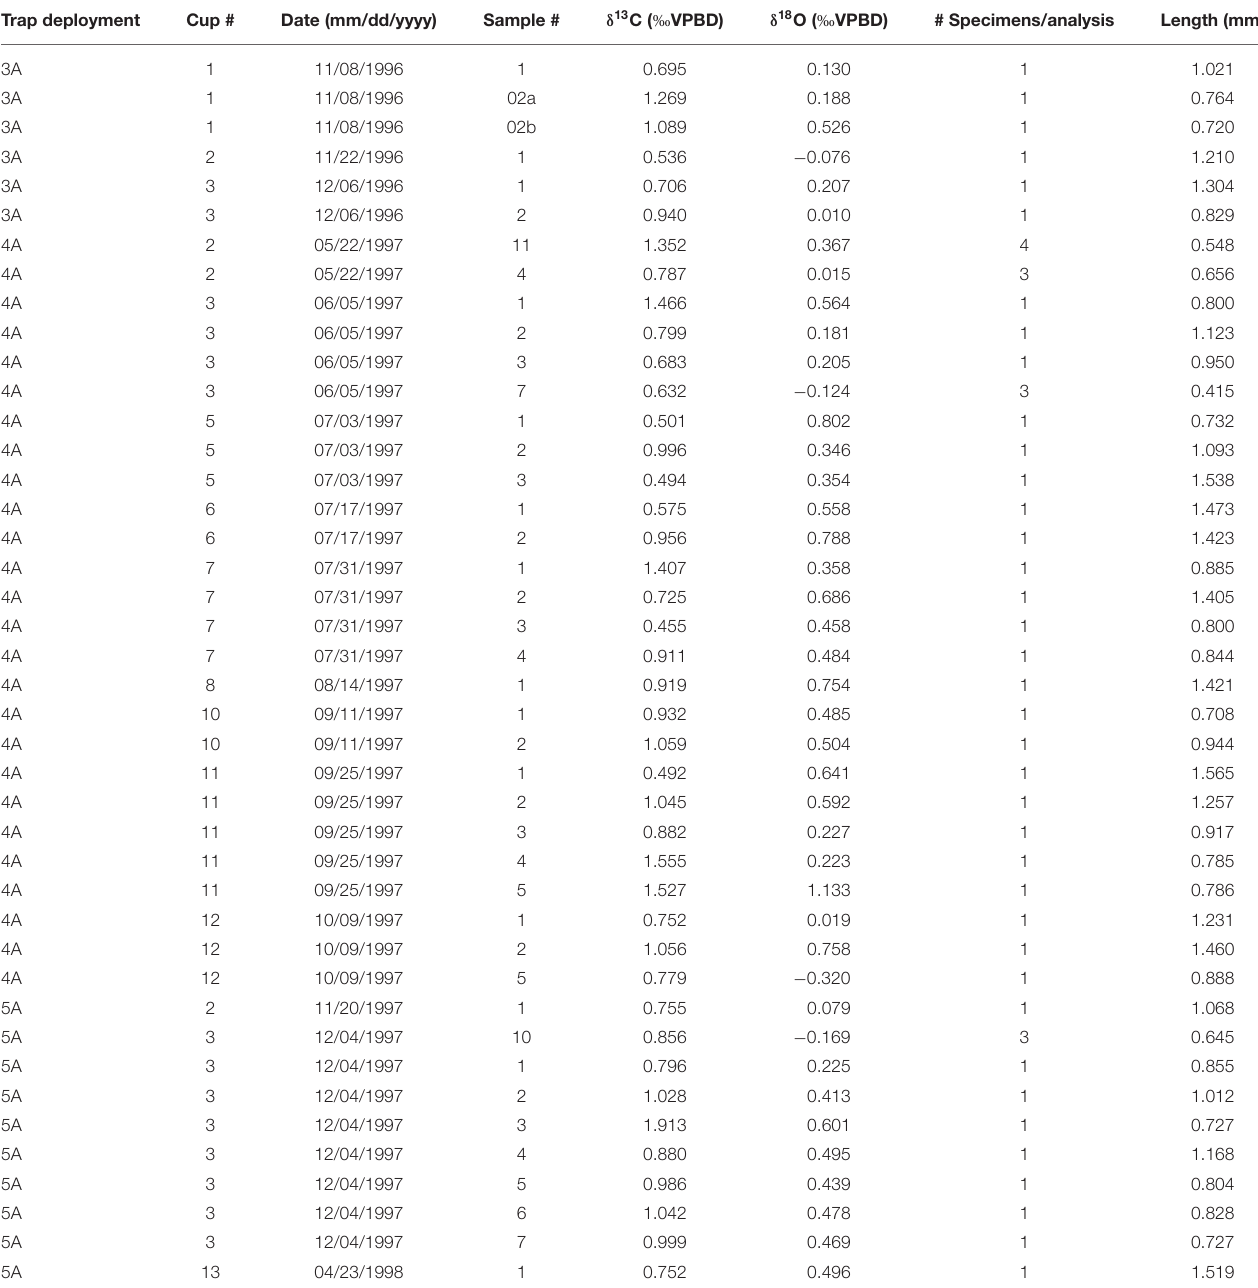
TABLE 2 | Carbon and oxygen isotope measurements of pteropod shells from the sediment trap. Trap